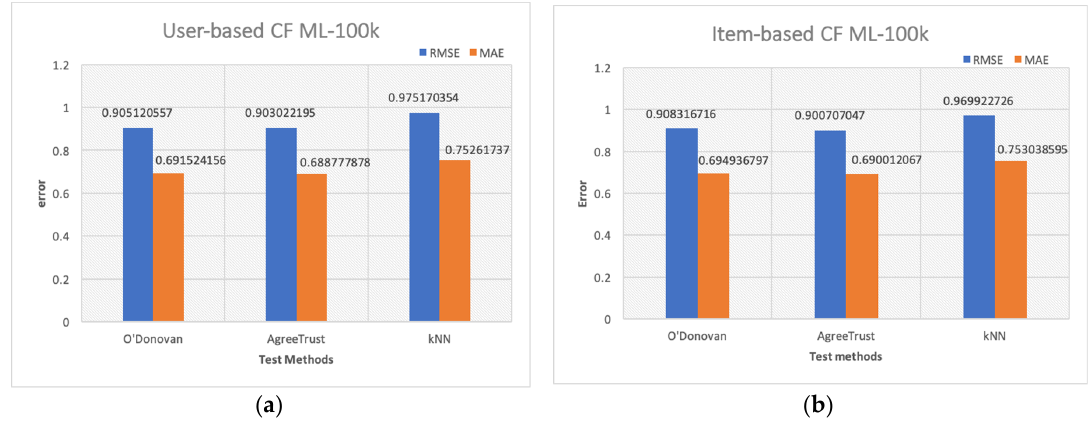
Figure 3. Results of the three CF methods for the ML-100k dataset: ( a ) user-based and ( b )